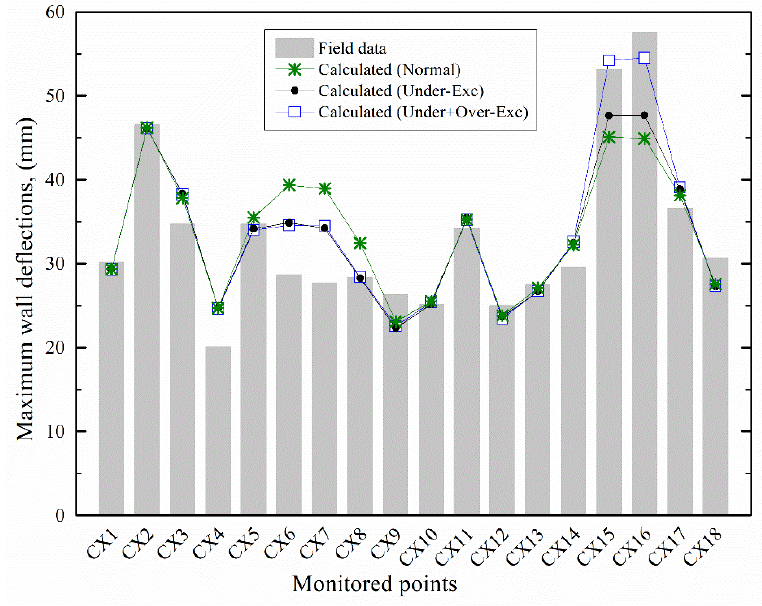
Figure 22. Summary of the observed and calculated maximum wall deflections.